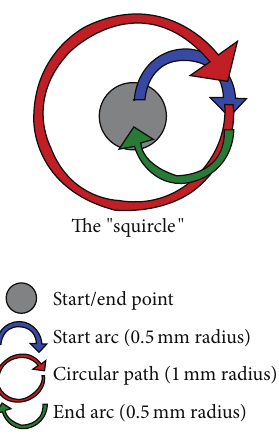
Figure 4: Illustration of weld path of swing FSSW